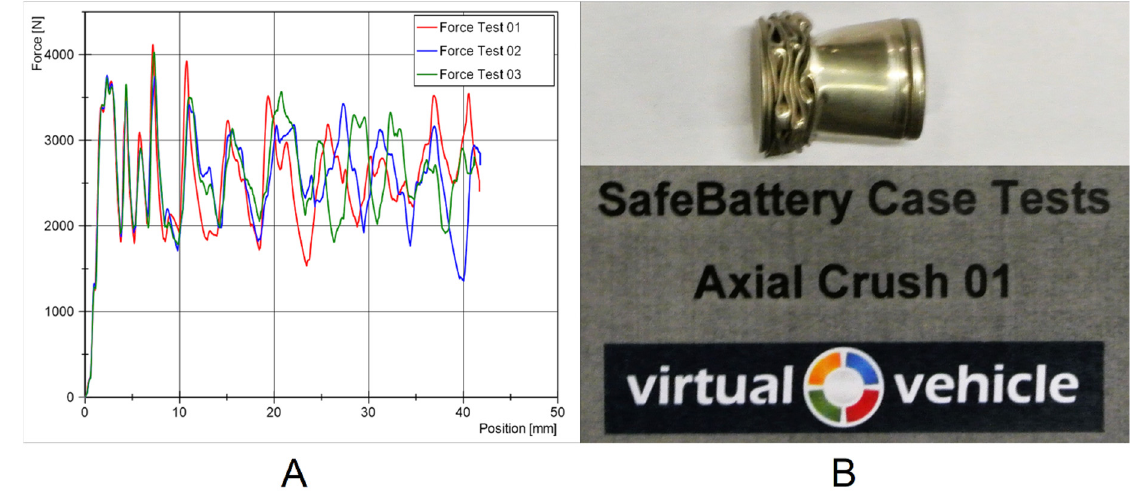
Figure A1. Results of the cell-case test for the load-case axial crush ( A ) and cell-case specimen after testing ( B ).